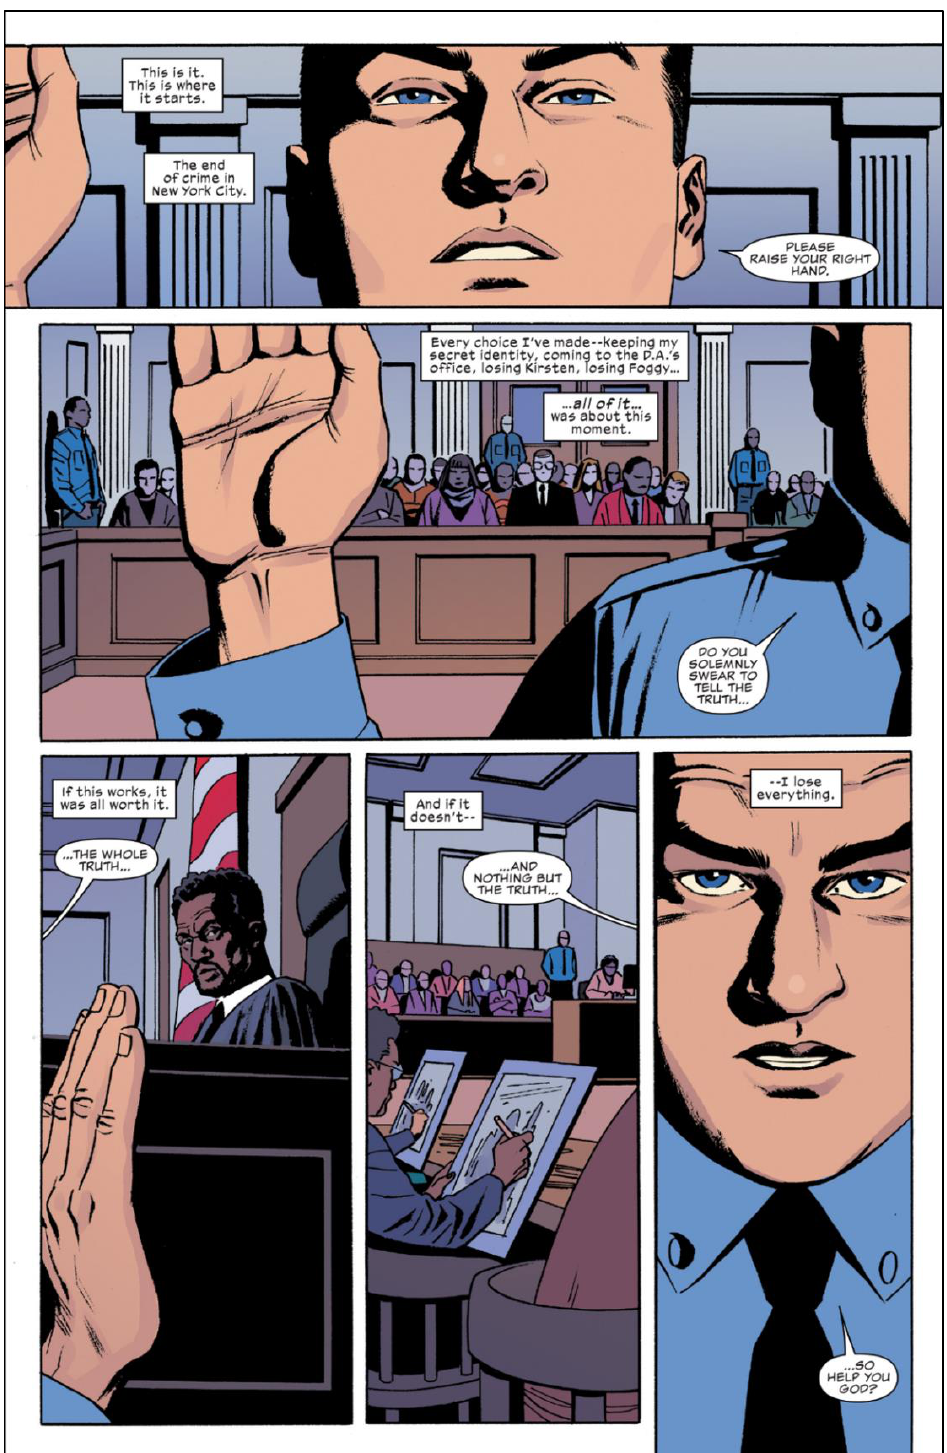
Figure 5. Panel from Soule’s Daredevil: Back in Black Vol. 5: Supreme #21, 2017. Image Credit: Goran Sudžuka © 2017 Marvel Characters,